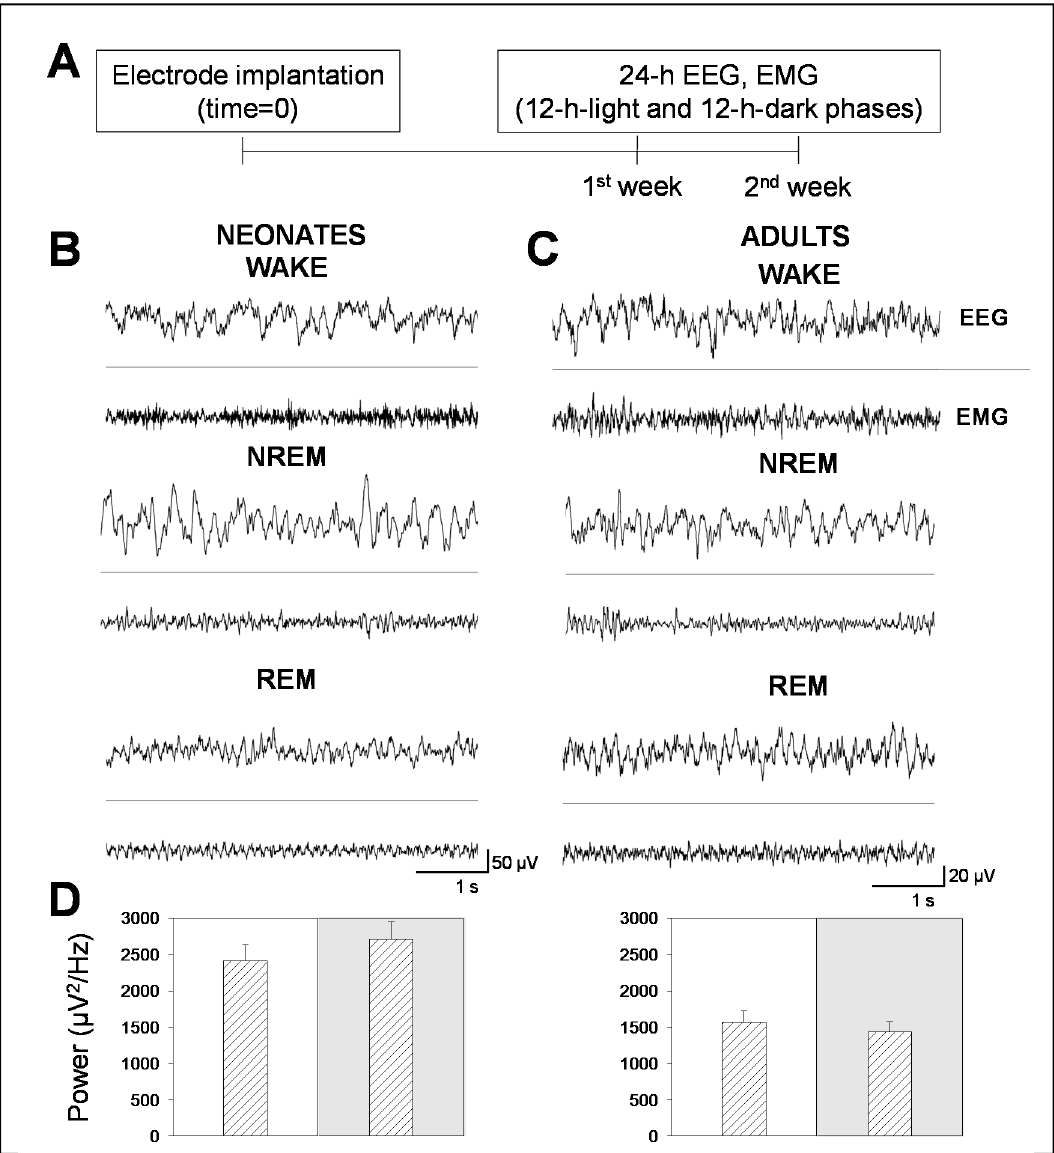
Figure 1. Electroencephalogram (EEG) and electromyogram (EMG) recordings in neonatal and adult mice. ( A ) Experi- mental design for EEG and EMG longitudinal recordings in mice. Following electrode implantation and a post-surgical recovery period, mice were recorded during two consecutive weeks in continuous 48 h recording sessions per week. ( B , C ) Representative 5 s EEG and EMG traces of behavioral states (wakefulness, non-rapid eye movement (NREM), and rapid eye movement (REM) sleep in neonatal (left) and adult (right) mice. ( D ) Bars represent the total power within the 0–100 Hz. frequencies in neonatal (left panel) and adult (right panel) mice. White or gray backgrounds represent 12 h-light or 12 h-dark phase, respectively. The graphs below show the total power as a function of the recording time in a 24 h period. Data shown as mean ± SEM of either 18 or 27 recordings retrieved from 6 neonatal or 11 adult mice,